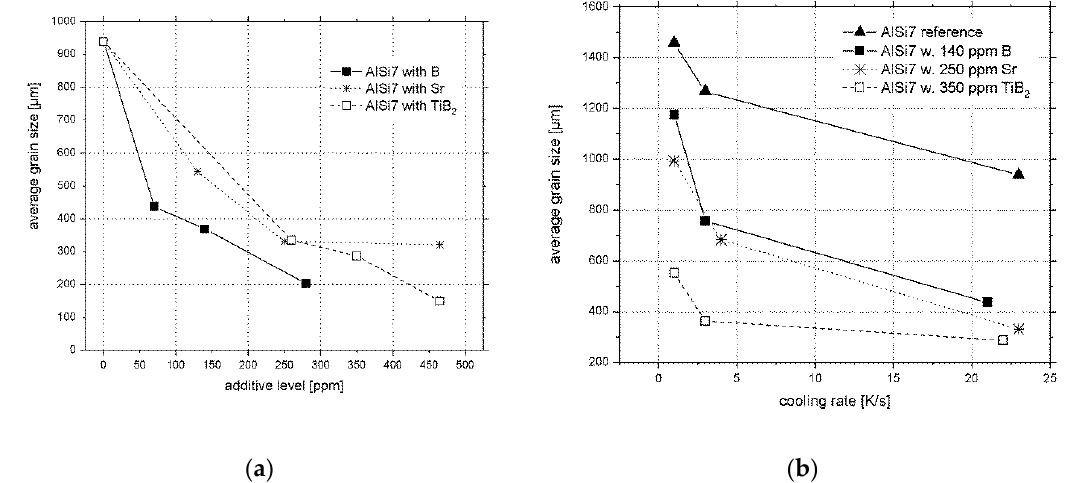
Figure 2. Average grain size of powder compacts, ( a ) as a function of Sr, B and TiB 2 additive content when quenched in water, ( b ) depending on cooling rate for reference material without additives and samples containing medium levels of Sr, B and TiB 2 addition as given in the